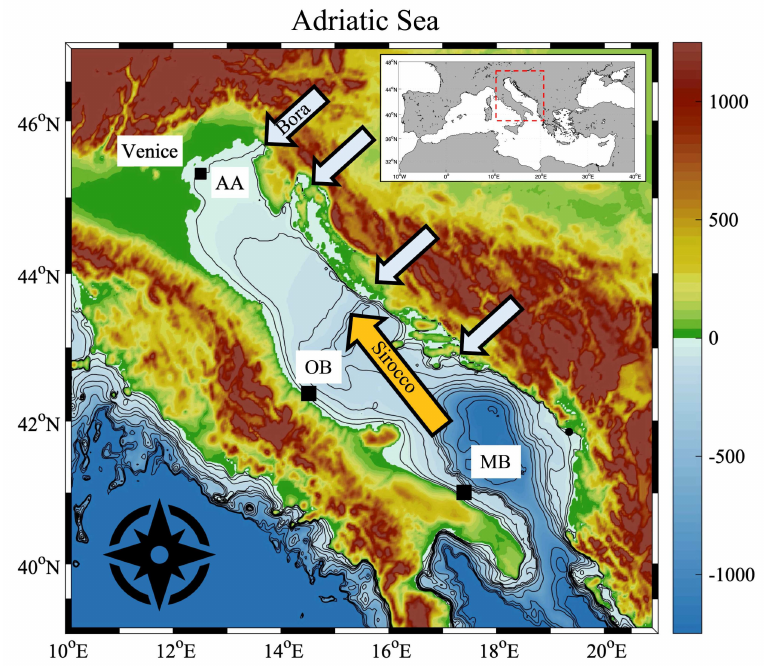
Figure 1. The Adriatic Sea bathymetry (blue shading from 0 to − 1250 m, in meters) and surrounding orography (green-to-brown shading). Stations for observational field data (from north to south): Acqua Alta oceanographic research platform (AA), Ortona wave buoy (OB), and Monopoli wave buoy (MB). In the inset, the Mediterranean region with at its center the Italian peninsula. The blue arrows sketch the approximate geographical position and direction of the principal northeasterly Bora wind jets, and the orange arrow marks the direction of the southeasterly Sirocco